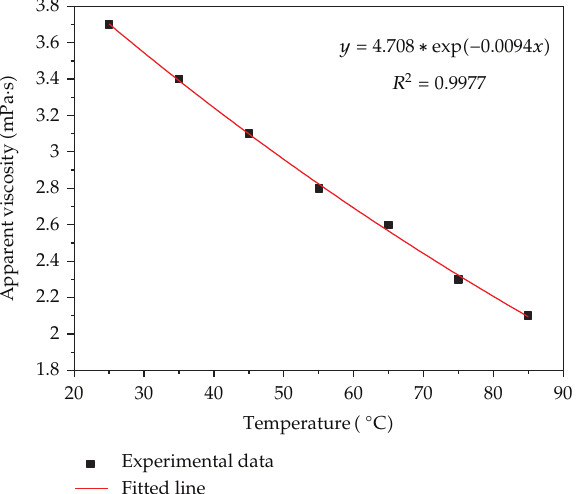
Figure 3: The evolution of oil viscosity at di ff erent temperatures.